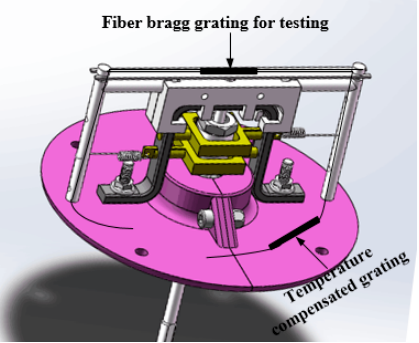
Figure 10. Fiber Bragg Grating paste position.